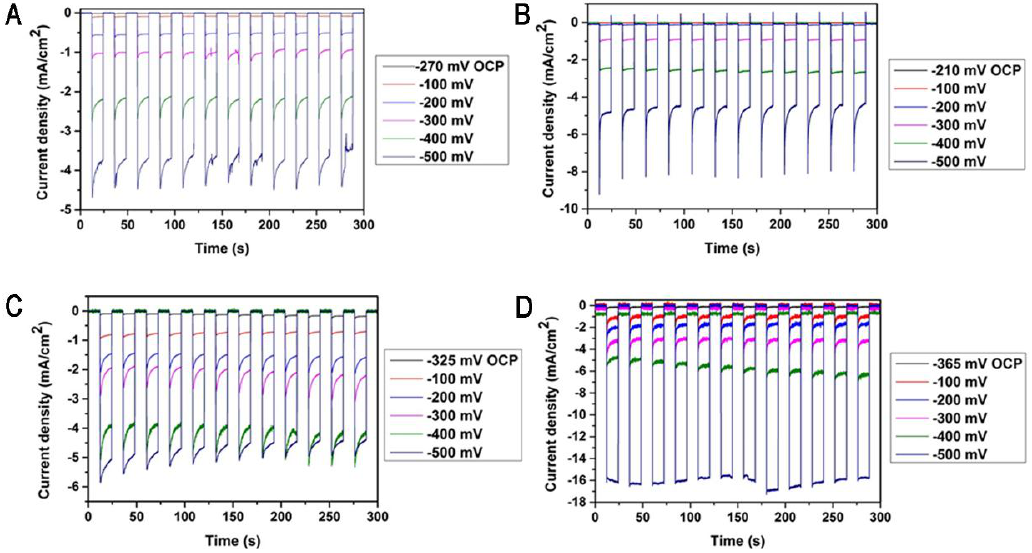
Figure 2. Current density measurements for the planar silicon ( A ), bare SiNWs ( B ), planar silicon coated with Fe 2 S 2 (CO) 6 catalyst ( C ) and SiNWs coated with Fe 2 S 2 (CO) 6 catalyst ( D ).